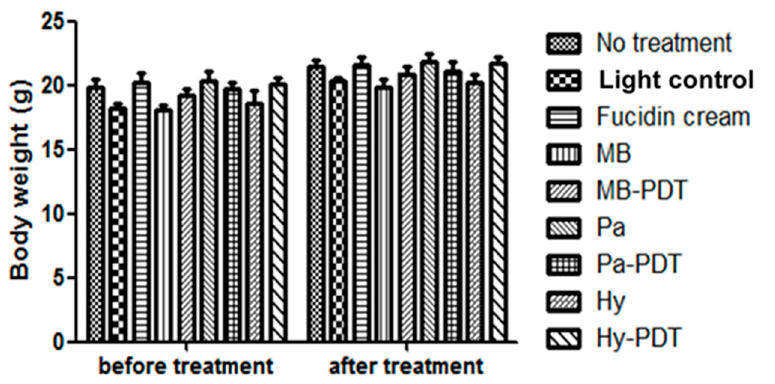
Figure 9. Body weight of different groups of mice before and after treatment with or without PDT. Data are mean ± SEM ( n = 6–10).